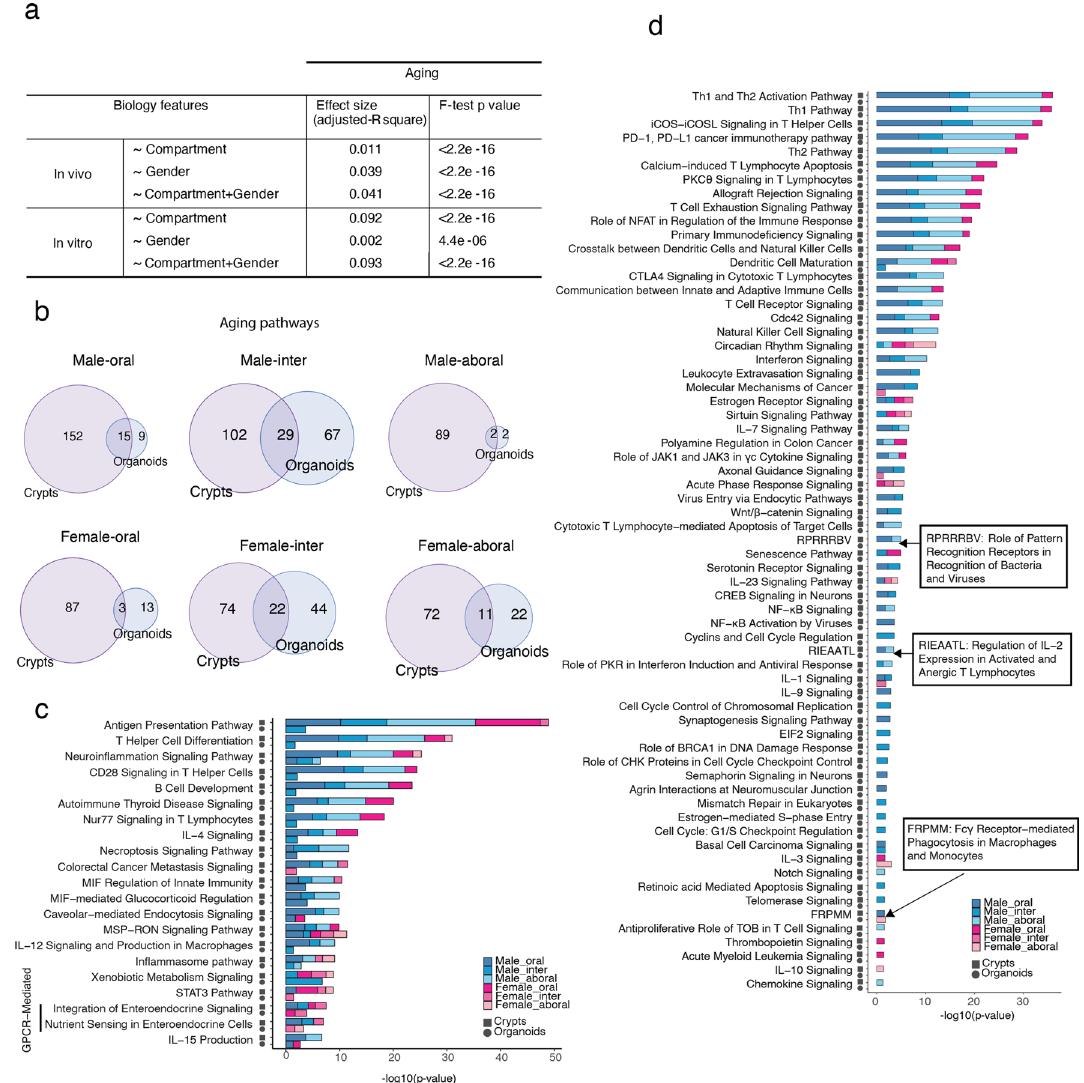
Figure 4. Characterization of organoids as an in vitro model for aging research. ( a ) Table of effect size of compartment, gender or (compartment + gender) on aging in vivo or in vitro by linear regression model. Effect size was defined by the adjusted coefficient of determination (adjusted R 2 ) of the linear model. F-test p-value was used to evaluate the linear model on our data. ( b ) Venn diagrams of the significantly enriched pathways during aging in different conditions between in vivo and in vitro. ( c ) Stacked bar chart of − log10 enrichment p-value (fisher exact test) in some typical relevant pathways found dysregulated in aging in vivo, which were kept in culture in at least one condition. ( d ) Stacked bar chart of − log10 enrichment p-value (fisher exact test) in some typical relevant pathways found dysregulated in aging in vivo, which were lost in culture. See also Supplementary Fig. gender on aging in vivo was higher (3.9%) than that of compartment (1.1%), while it almost disappeared (0.2%) in vitro differently from the compartment effect on aging that were enhanced by culturing. This could be caused by the strong differences observed in gender features after culture. The effect of compartment on aging in vitro reached up to 9.2%, that could be disclosed by the shrink of aging features and the maintenance of compartment features in culture. About 12% of aging-associated pathways were maintained in culture (Fig. 4b and Supplementary Table S4). To specify how aging-induced transcriptional alterations changed after culture, we summarized functional path- ways conserved or disappeared upon 14 days of culturing. Few of the aging-related pathways like some of the cellular immune response, intracellular signaling, cellular growth and proliferation, degradation, and metabolic pathways were found enriched also in organoids, even though to a massive lower extent (Fig. 4c, Supplementary Fig. S9a and Table S4). Most of these pathways were statistically enriched in multiple in vivo conditions (e.g. in multiple compartments and/or in both the genders), but in organoids were mostly found only in one condi- tion (Supplementary Fig. S9b). This may indicate that in some conditions (e.g. male-intermediate) the effect of aging in altering the transcriptional landscape may be stronger than in other conditions and, therefore requiring